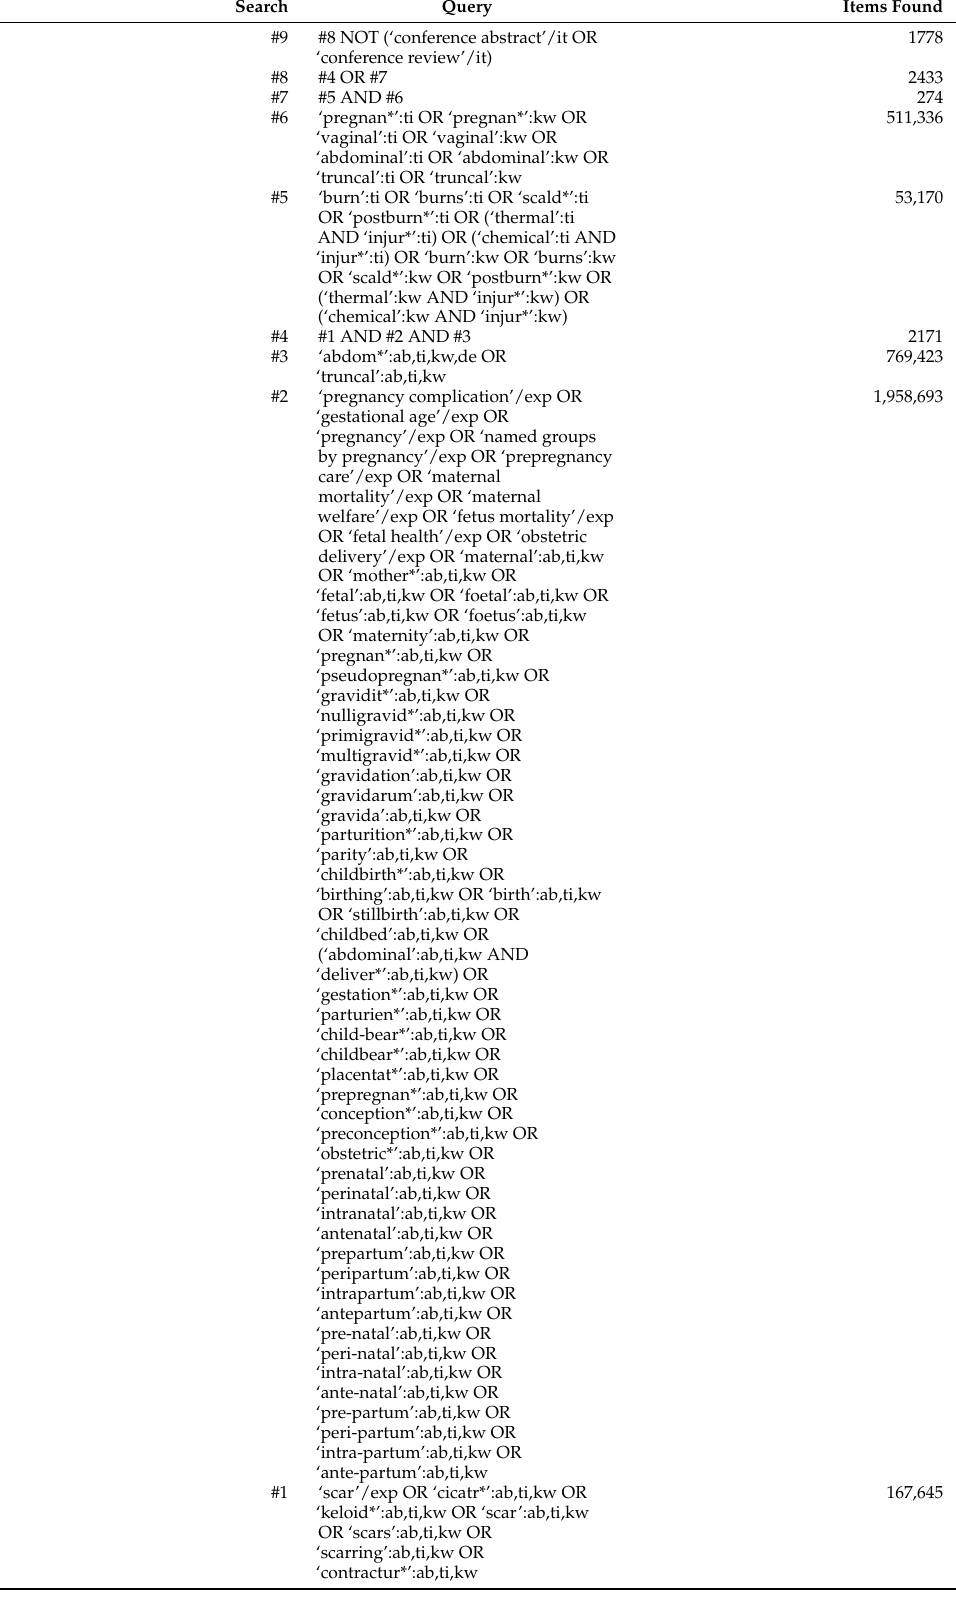
Table A2. Embase.com Session Results (23 April